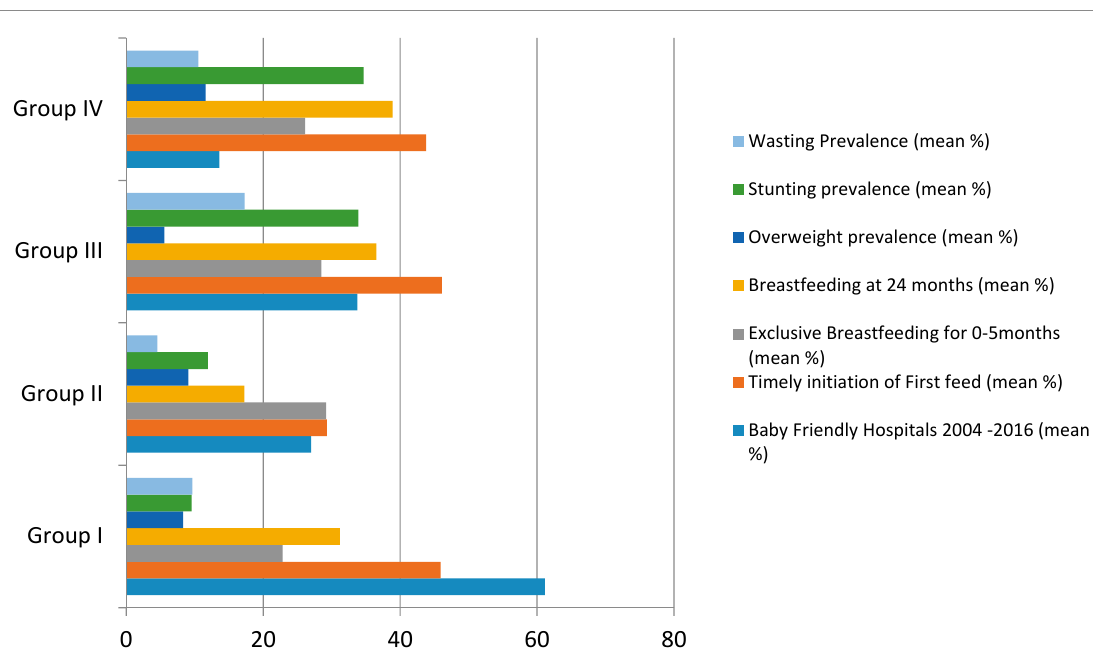
Figure 1. Bar chart illustrating the relationships between nutritional status in the different groups under study and breastfeeding and Baby-Friendly status in the respective group (mean % designates the mean percentage prevalence for each country by group in the region under study) .